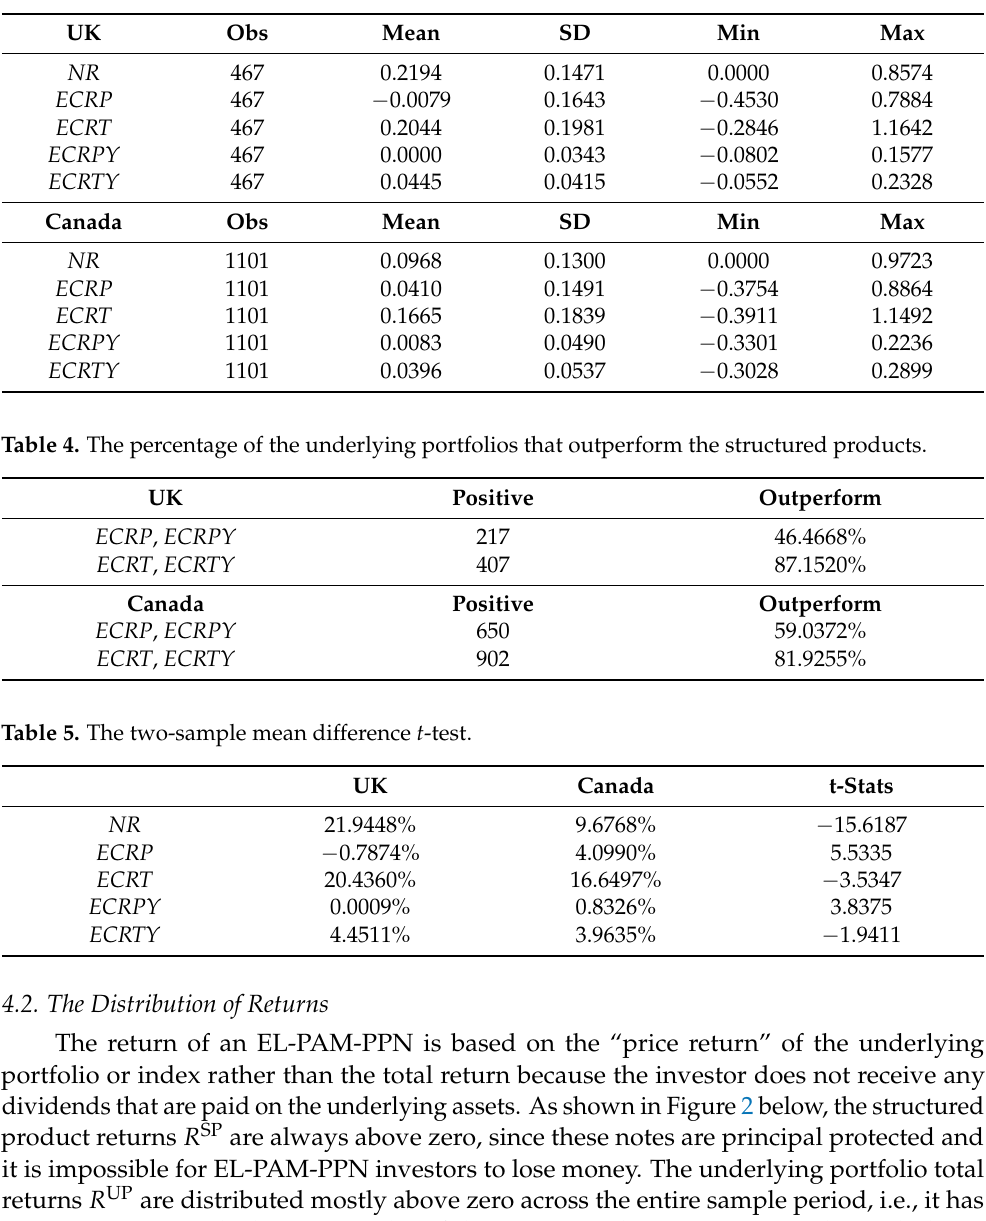
Table 3. The summary statistics of the note return and the excess return.